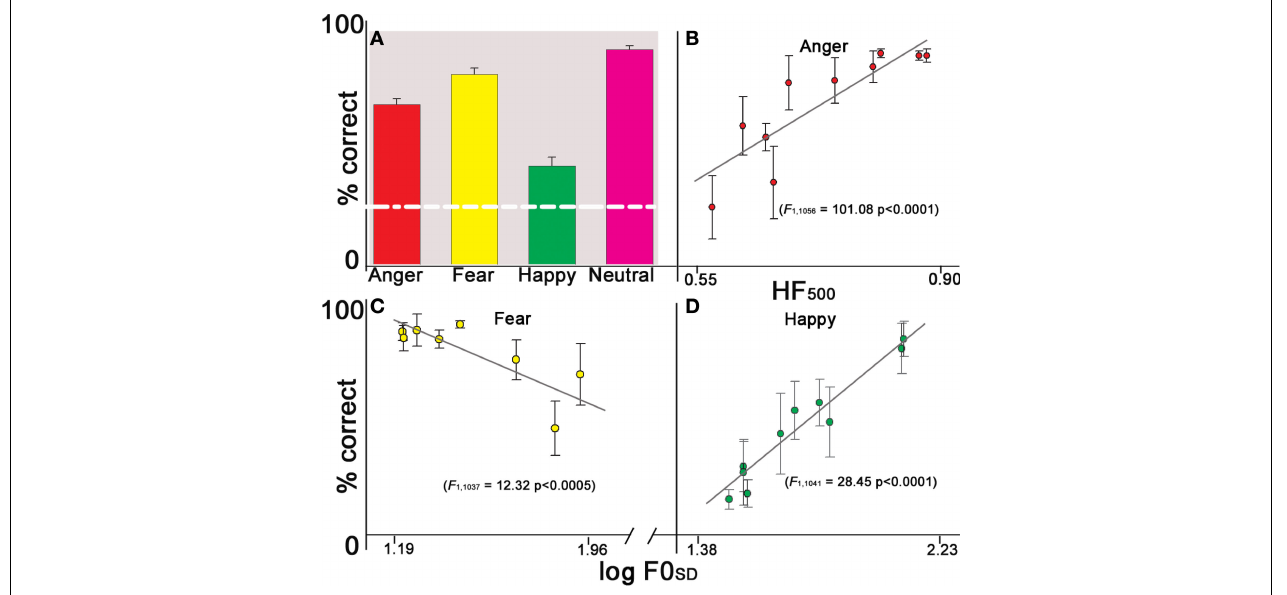
FIGURE 3 | Identifi cation performance as a function of acoustic cue saliency levels. (A) Mean performance across all emotion choices; error bars refl ect standard error of the mean of the raw data. White dotted line indicates chance performance. (B) Anger: as HF decreases accuracy increases. (D) Happiness: as F0